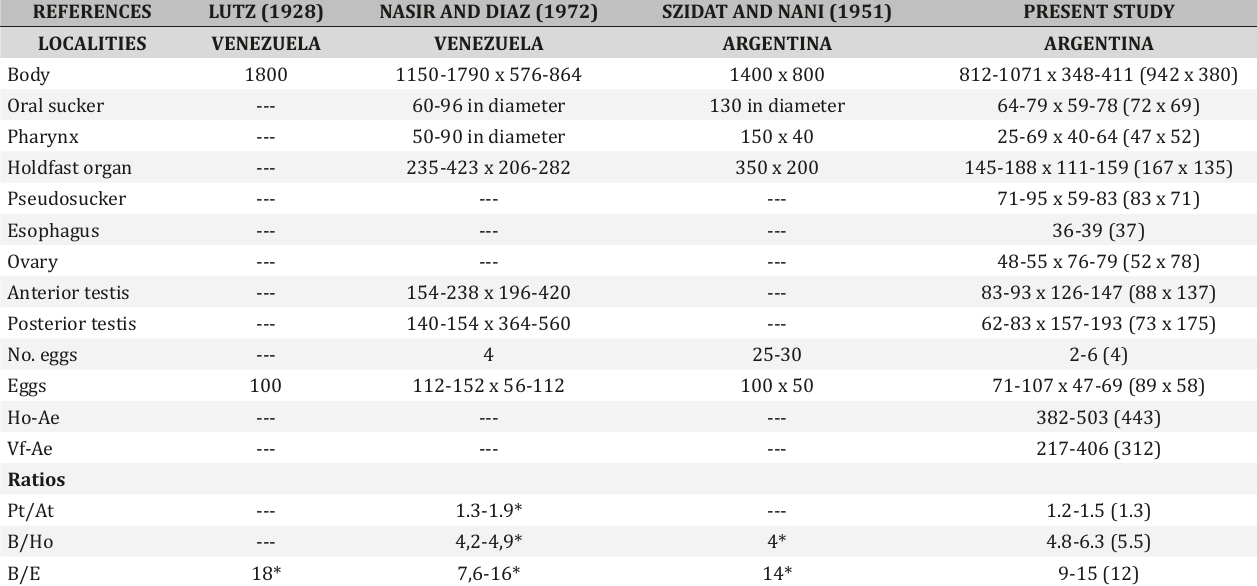
Comparative measurements (in micrometers) of